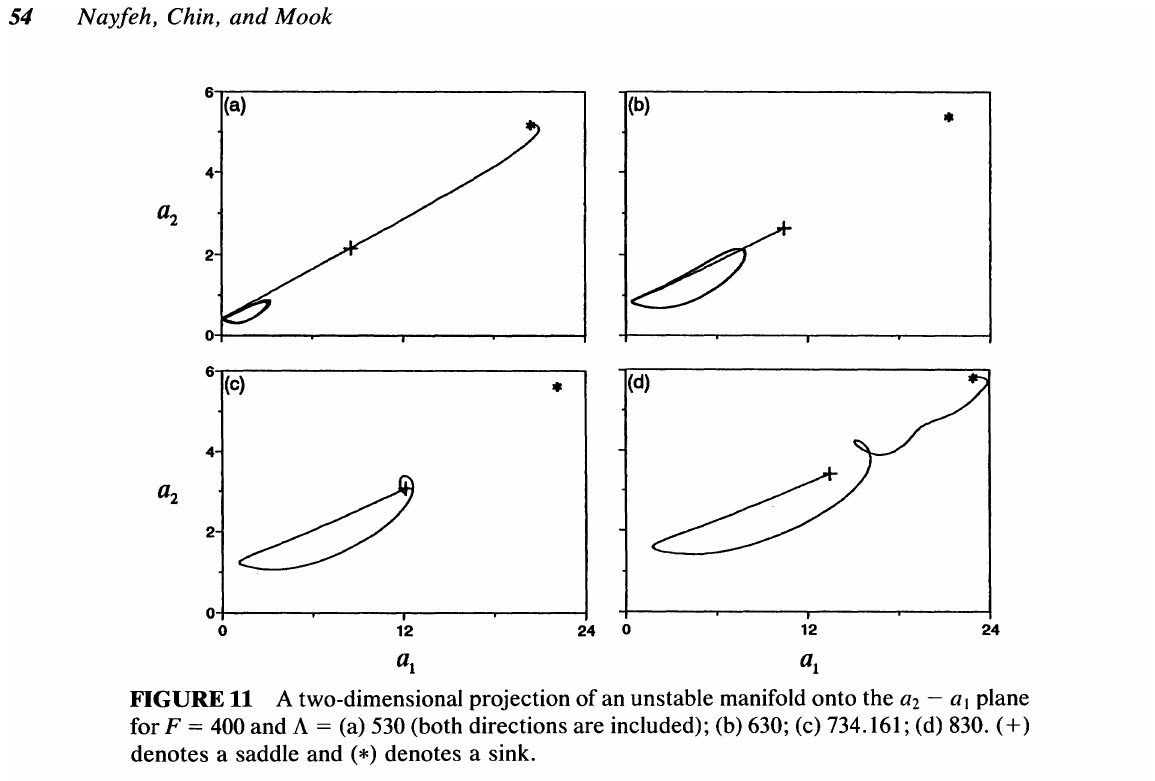
FIGURE 11 A two-dimensional projection of an unstable manifold onto the az - a, plane for F = 400 and A = (a) 530 (both directions are included); (b) 630; (c) 734.161; (d) 830. (+) denotes a saddle and (*) denotes a